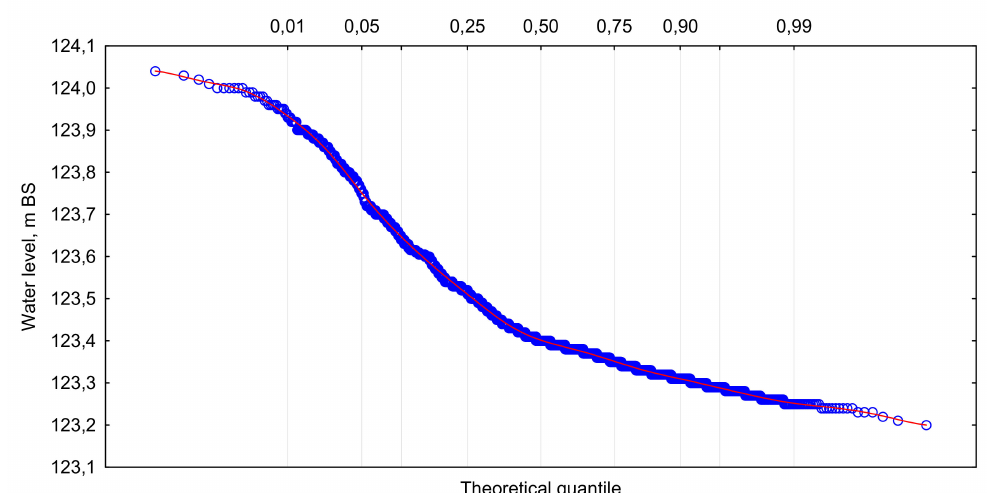
Figure 2. The curve of the theoretical quantiles of average daily water levels in the upper reach (2008, 2009, 2014 – 2020).